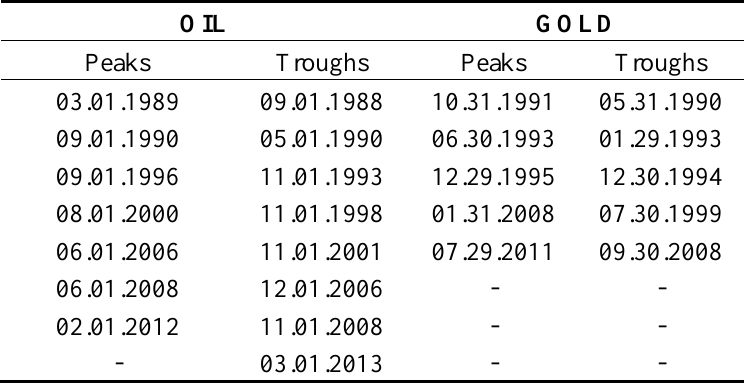
Table 1. Peak and trough dates of the oil and gold markets.